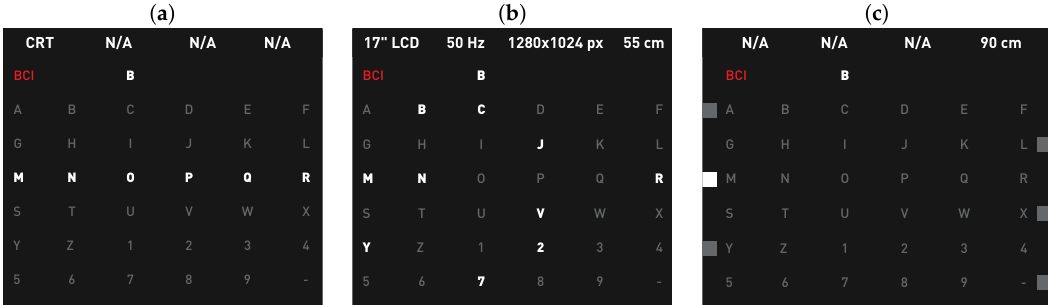
Screen Type: 17" LCD Refresh rate: 50 Hz Resolution: 1280x1024 px